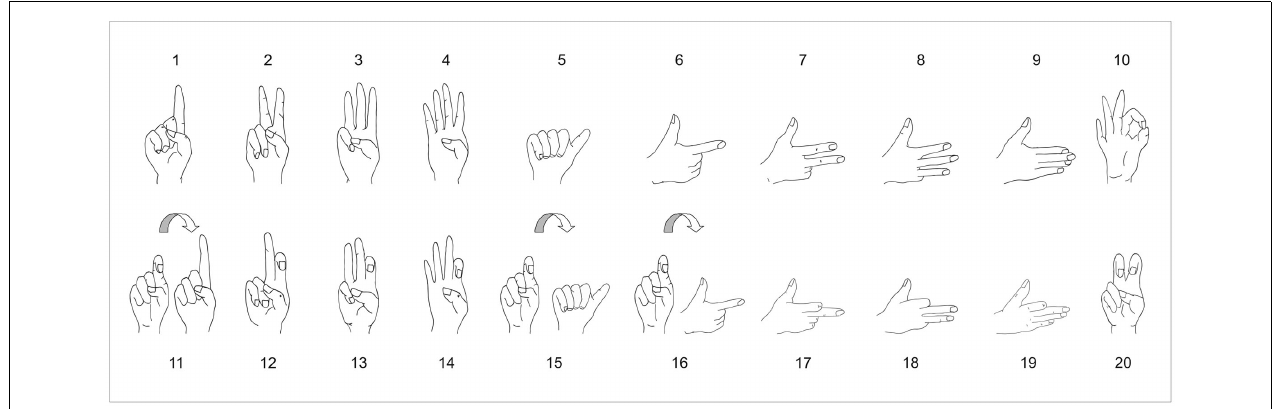
FIGURE 1 | Finger-counting system in Korean Sign Language from the viewer’s perspective. Note that numbers 11, 15, and 16 are signed in a sequential movement of the same hand.